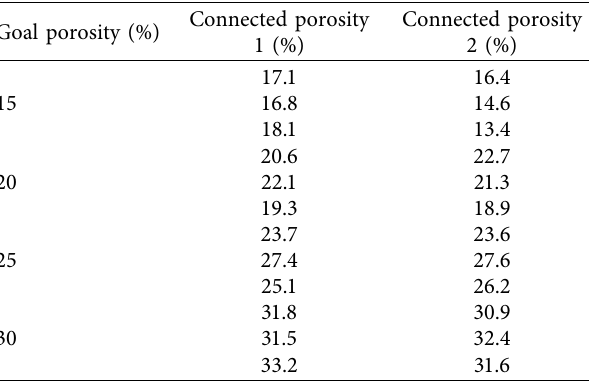
Table 8: Test results of specimen with 150mm × 150mm × 300mm. Goal porosity (%)